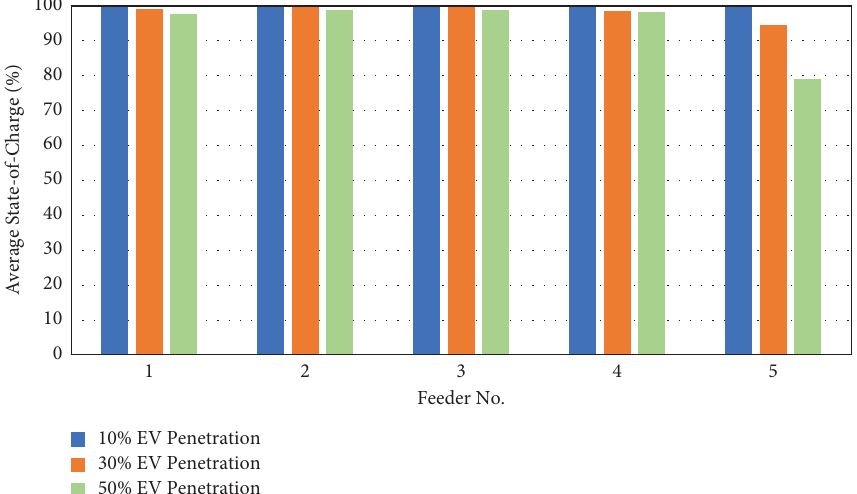
Figure 21: Average SoC under the three scenarios of EV penetration for smart charging.